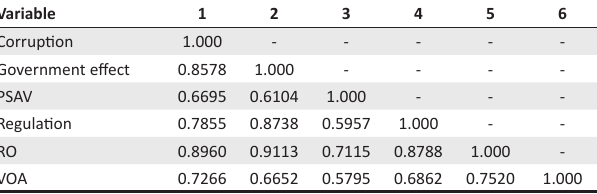
TABLE 1: Correlation matrices for institutional governance.